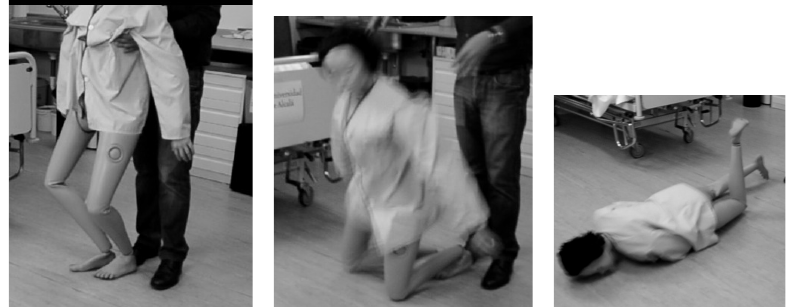
Figure 1. Syncope fall sequence using a dummy. From left to right: initial position, impact of the knees with the ground, and end position on the